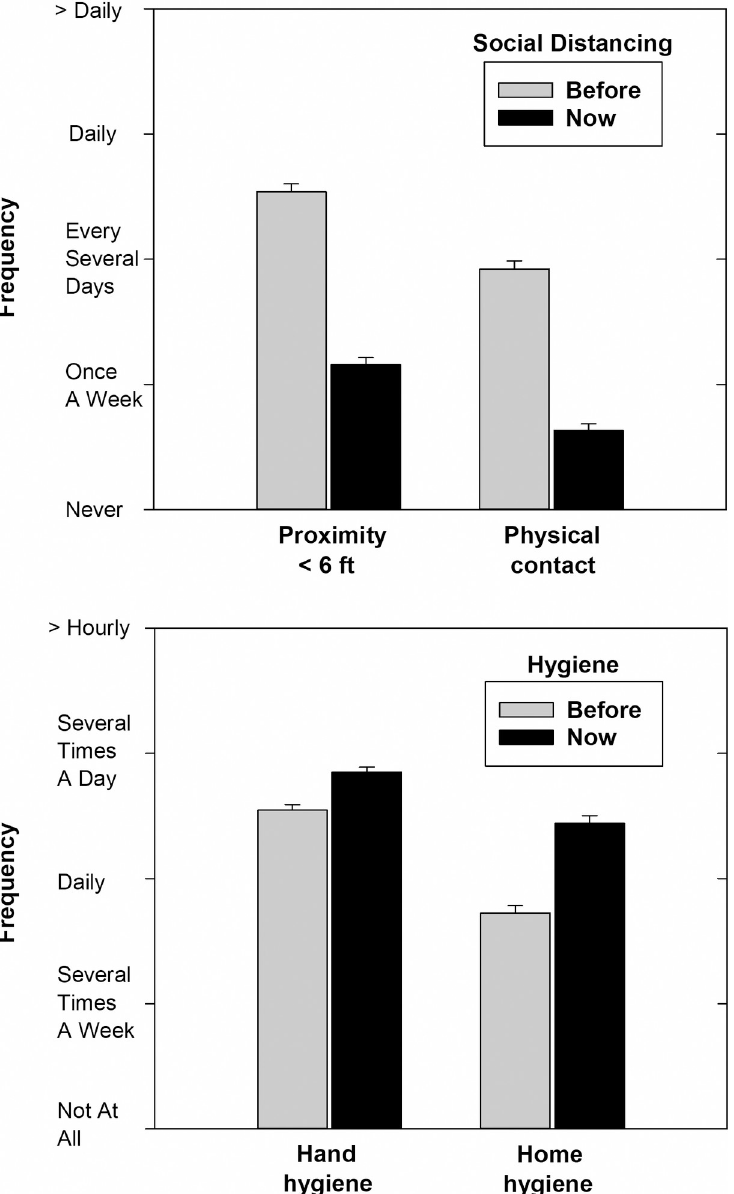
Fig 1. Mean frequencies of two social distancing mitigation behaviors (upper panel) and two hygiene mitigation behaviors (lower panel) before and during the COVID-19 pandemic. Error bars represent standard errors of the